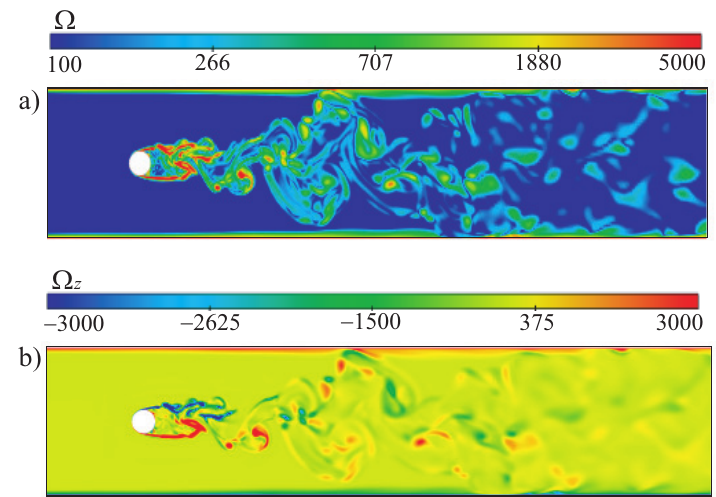
Figure 8. Contours of the modulus of the vorticity vector ( a ) and the z -component of the vorticity vector ( b ) in the symmetry plane for Re c = 39,809.